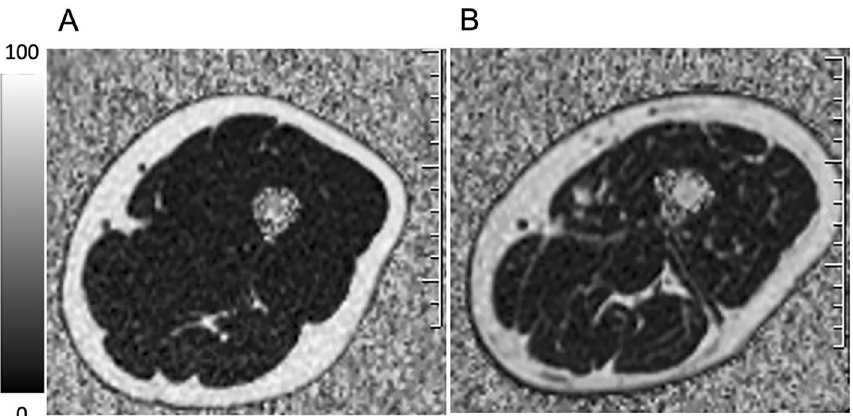
Figure 2. Representative MRI PDFF of thigh in control and T2DM. ( A ) Control volunteer without T2DM, Female, 55 years old. IMAT PDFF extensors = 10.60%, IMF PDFF extensors = 2.75%, IMAT PDFF flexors = 17.00%, IMF PDFF flexors = 4.10%. ( B ) T2DM patient, Female, 55 years old. IMAT PDFF extensors = 18.90%, IMF PDFF